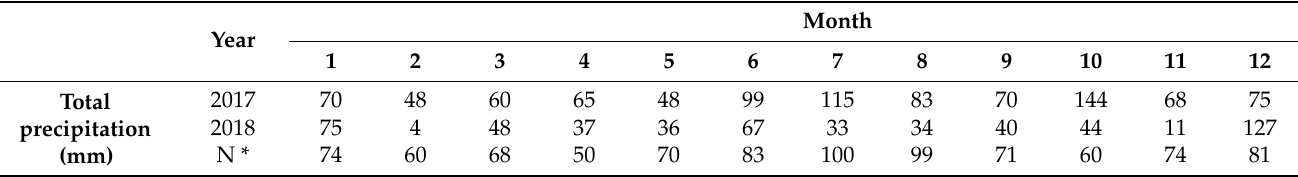
Table 3. Total precipitation in the Liberec Region in 2017 and 2018